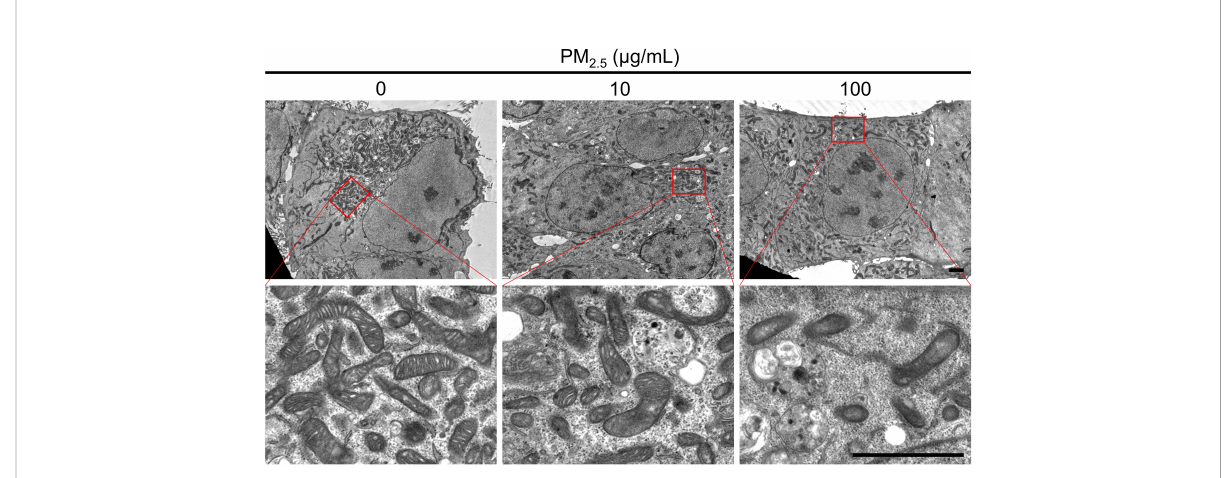
FIGURE 7 Ultrastructural analysis using TEM. TEM images represent the mitochondrial morphology of PM 2.5 -treated and non-treated HL-1 cells. Each representative image was acquired from three TEM images per condition. Magni fi ed images are presented in each bottom panel. Scale bar = 2 m